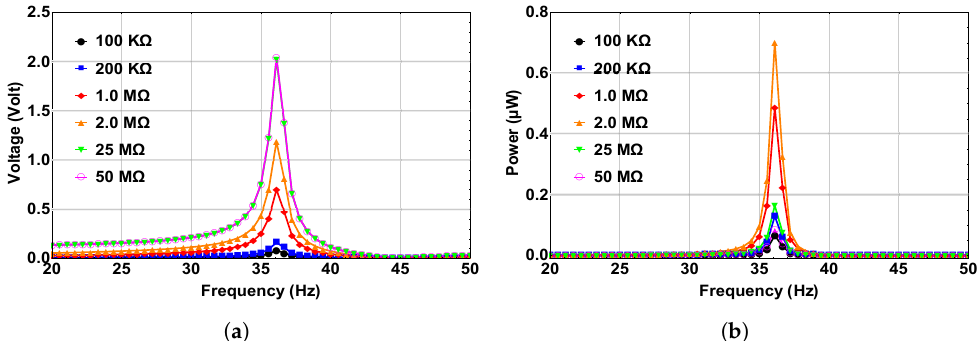
Figure 11. ( a ) Maximum output voltage. ( b ) Maximum output power at different resistance values for a separation distance of 5 mm and an excitation level of 0.5 g.